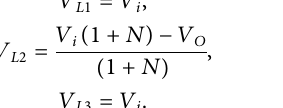
2 is ON, and Mode 7: as Figure 3G depicts, all three switches S are turned OFF. The battery current conducts the winding L 1 , L 2 , and L 3 . Battery current conducts through the windings L 1 to D 1 , D 4 , C, and the load. Through L 2 current conducts D 2 , D 5 , C, and the load. Through L 3 current conducts D 3 , D 6 , C, and the load.